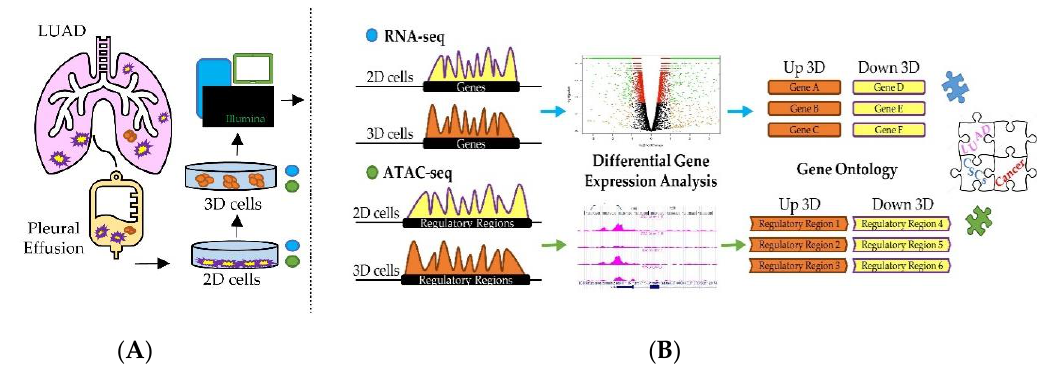
Figure 1. Graphical overview of the investigation. ( A ) 2D and 3D cell cultures were obtained from the stable NCI–H460 cell line obtained from the malignant pleural effusion of a lung adenocarcinoma (LUAD) patient. Total RNA was extracted and subjected to RNA-seq. Nuclei were isolated and processed to perform ATAC-seq. ( B ) Computational workflow developed to identify differentially expressed genes, pathways and biological processes in 3D compared to 2D cell cultures.